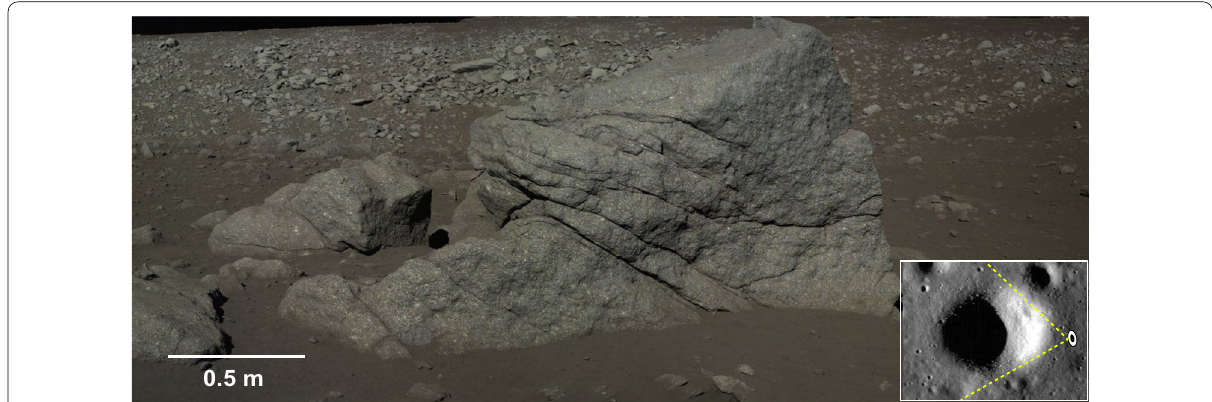
Fig. 7 Abundant meter-scale boulders have been excavated by the Ziwei crater. Most of the blocks are visible on the crater wall and rim. This mosaic was obtained by the panoramic camera on the Yutu rover. The inset figure is the same as that of Fig. 1a, and the view shows the proximate zone of the main